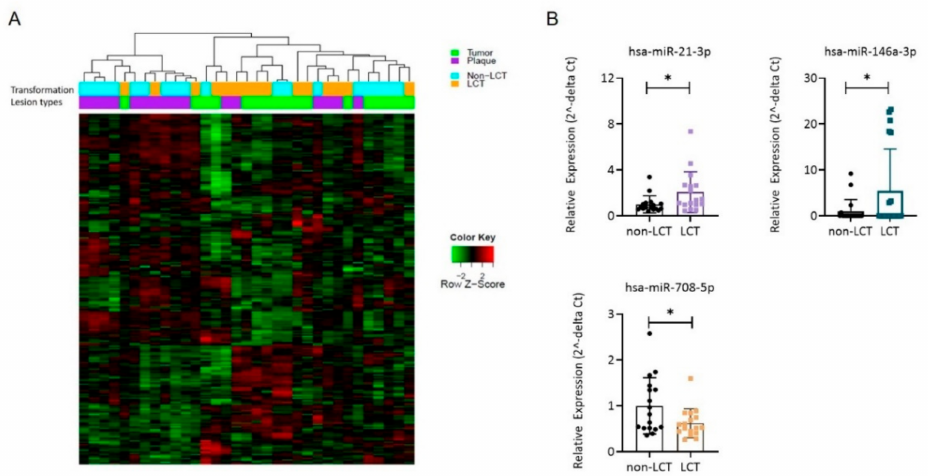
Figure 2. miR signatures in LCT-MF. ( A ) Heatmap of unsupervised two-way hierarchical clustering based on global miR analysis. ( B ) qRT-PCR-based analysis of miR expression in LCT-MF and non-LCT lesional skin samples. The 2ˆ (-delta delta CT) method was used as a relative quantification strategy for data analysis. Results are shown as means ± SD, and differences were tested for significance using Student’s t test (* p <